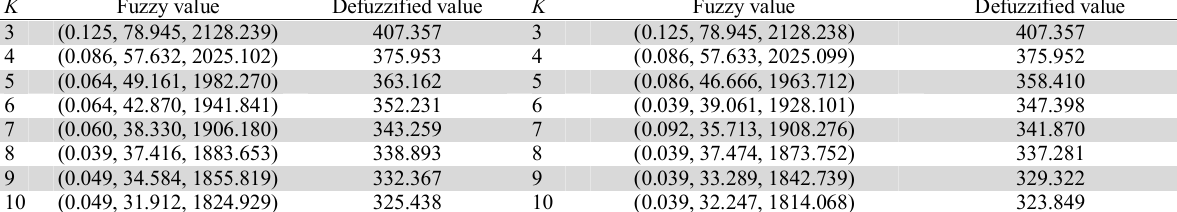
Average and best results for the fuzzified version of Fisher's Iris